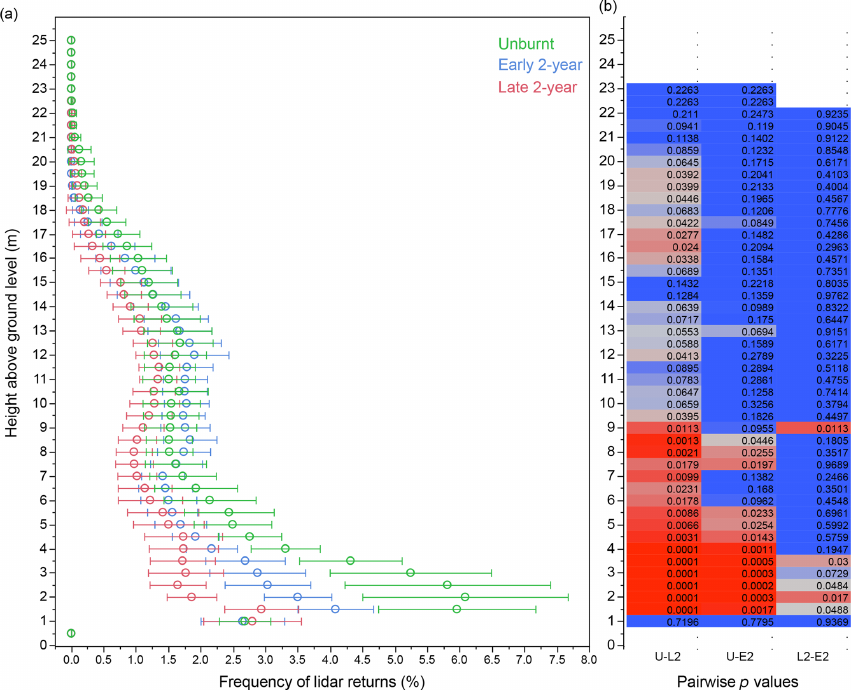
Figure 7. Effect of biennial fire season on woody vertical profile structure with unburnt treatment in green, early season biennial in blue, and late season biennial in red. (a) Dots and error bars represent the mean and 95% confidence interval for the 30m × 30m subplots ( n = 18). Some returns from lower height classes may have arisen from herbaceous material. (b) Pairwise comparison of differences in means on a per height class basis. U–L2 is unburnt vs. late season biennial, U–E2 is unburnt vs. early season biennial, and L2–E2 is late season vs. early season biennial. p values are shaded with values < 0 . 05 in